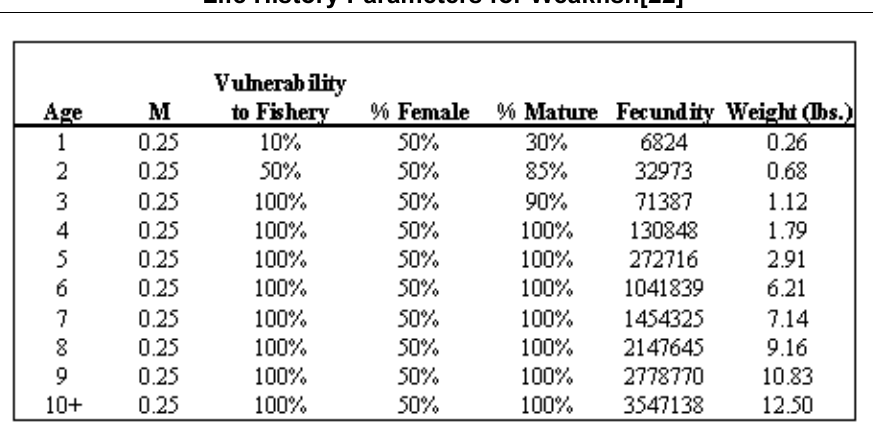
Life History Parameters for